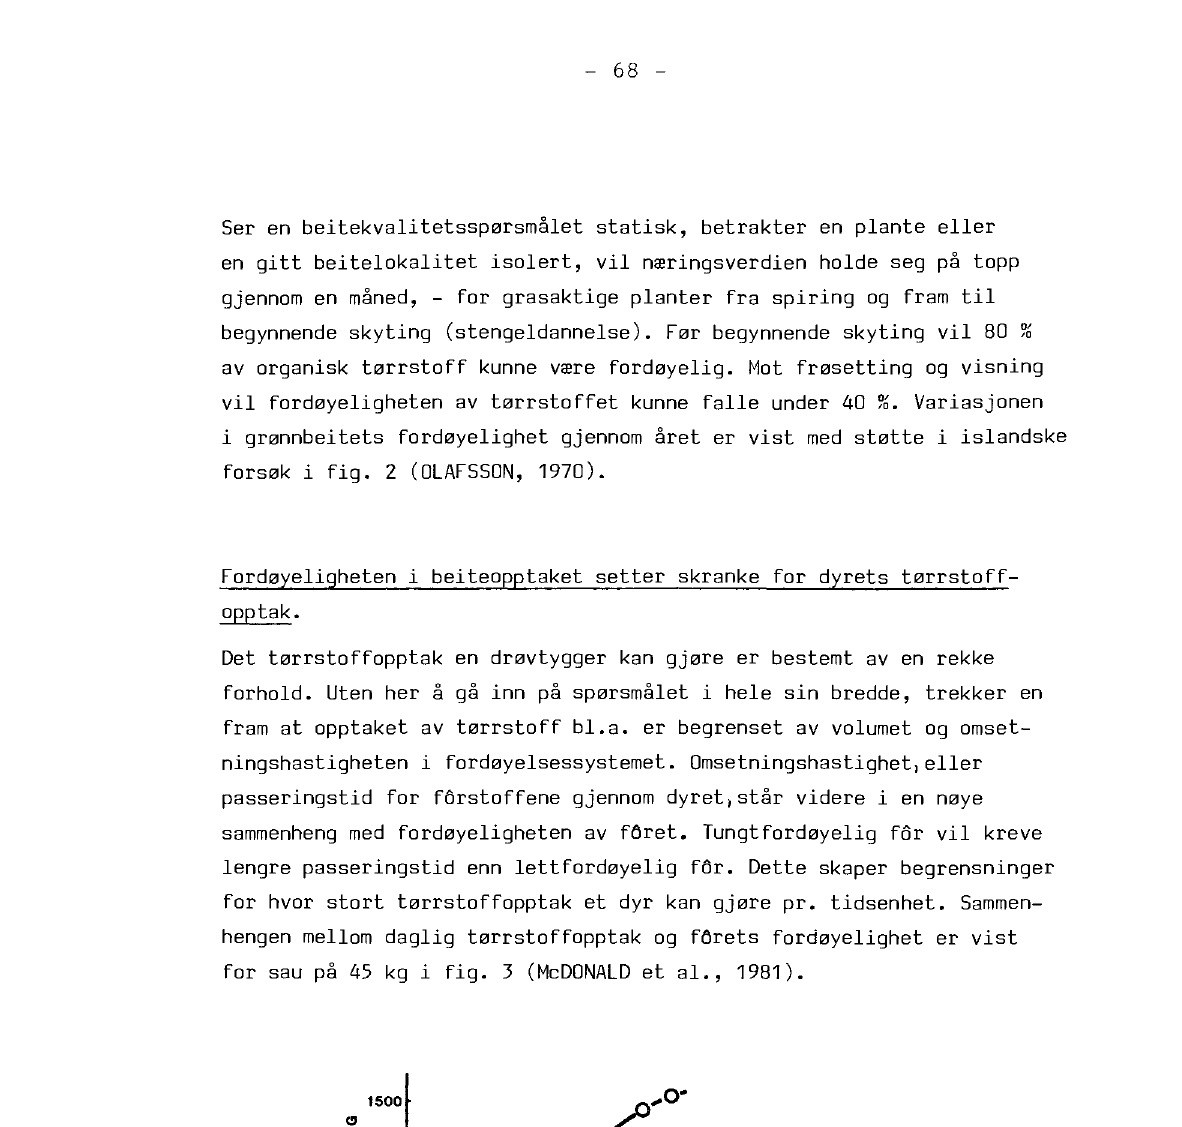
Fig. 3. Tørrstoffopptak pr. dag for sau på 45 kg (y) som funksjon av fordøyelighet i beitet ( x ). Y= - 1873.29 + 80.54x - 0.48x